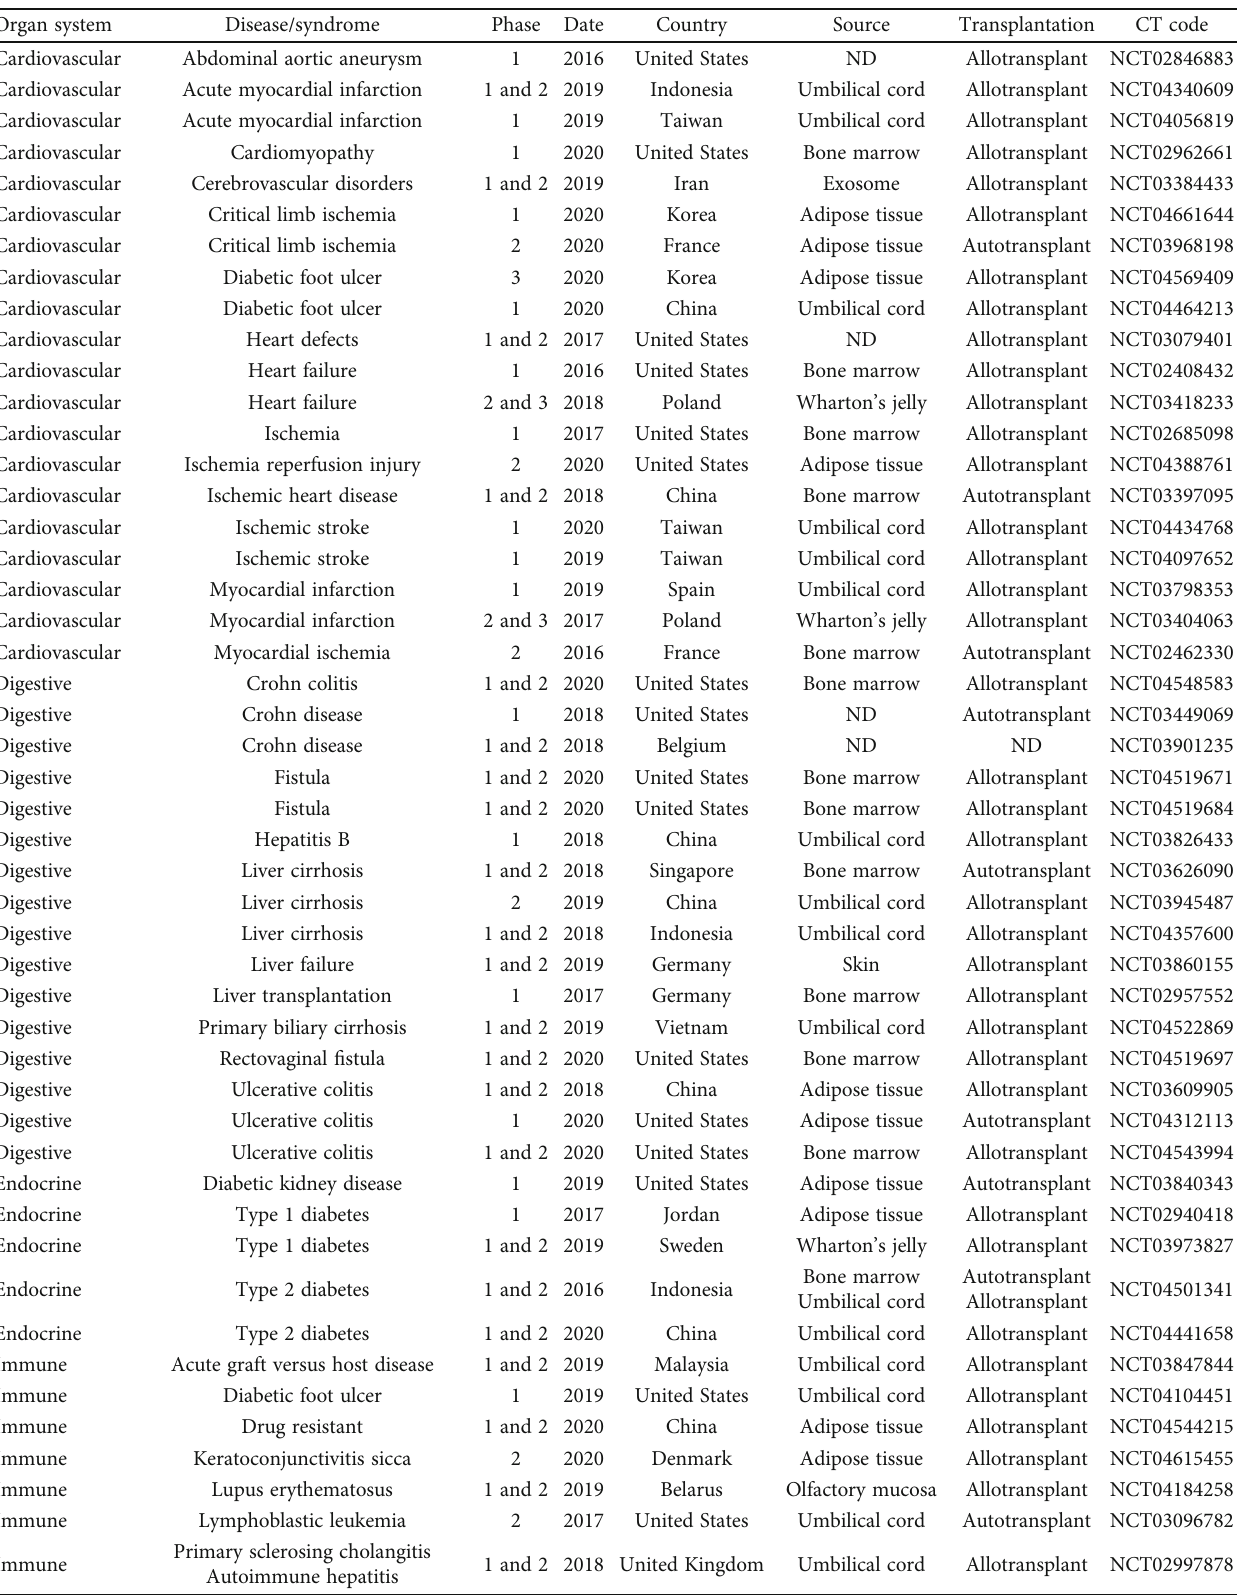
Table 3: Recruiting clinical trials on mesenchymal stromal/stem cell-based therapy started during 2016-2020 (U. S. National Library of